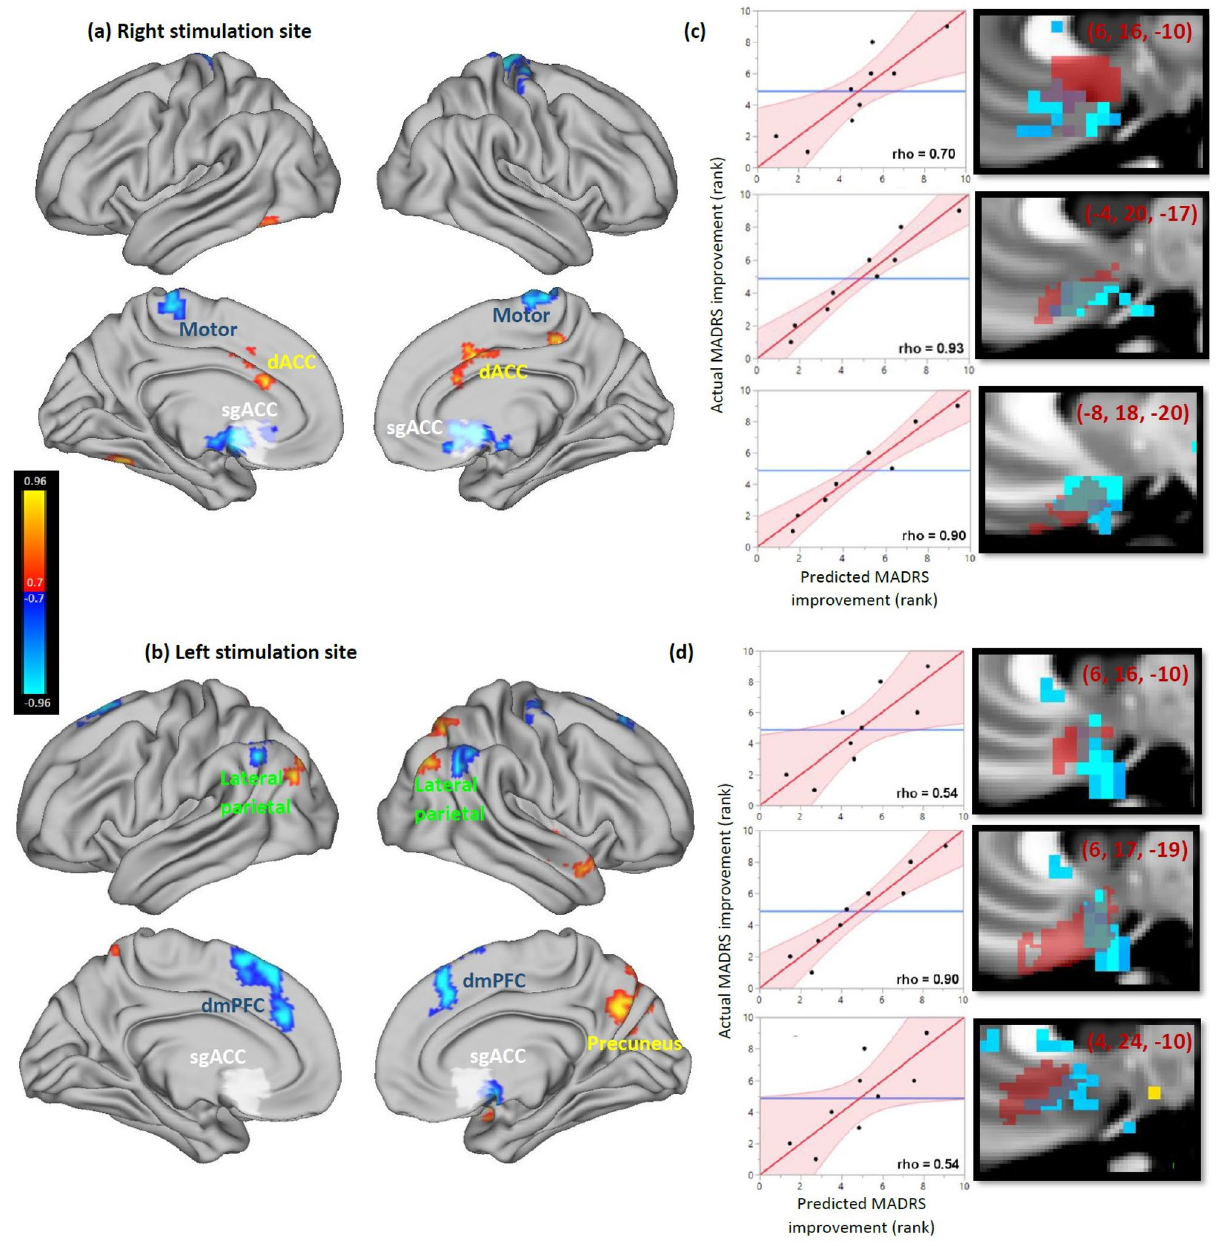
Figure 6. Connectivity profile associated with increased antidepressant efficacy of stimulation sites. White regions depict the a priori subgenual ROI. Clusters detected with threshold of r > 0.8 (uncorrected p < 0.001), minimum extent of 729 mm 3 , and cluster significance defined at p < 0.05. ( a ) Antidepressant response was significantly predicted by right stimulation site anti-correlation with bilateral sgACC, anti-correlation with motor cortex, and positive correlation with dorsal ACC (corrected p < 0.05). ( b ) Antidepressant response was significantly predicted by left stimulation site correlation with right precuneus and anti-correlation with right sgACC, bilateral lateral parietal lobe, and bilateral dorsomedial prefrontal cortex (corrected p < 0.05). ( c , d ) Antidepressant response was inversely related to seed-based connectivity of both stimulation sites with contralateral subgenual regions defined by a more recent cortical parcellation. Left panels depict the relationship between predicted and actual MADRS improvement, while right panels depict the overlap between the corresponding ROI (red) and the voxels whose stimulation site anti-correlation predicts MADRS improvement (blue). MNI coordinates of the center of each ROI are reported in maroon. ( c ) Right stimulation site connectivity with the a priori subgenual ROI (predicted MADRS change) was significantly predictive of antidepressant response (rho = 0.70, p = 0.035). This relationship was stronger when using exploratory subgenual ROIs based on a more recent cortical parcellation (rho = 0.90 and 0.93, p = 0.0009 and 0.0003). ( d ) Left stimulation site connectivity with the a priori subgenual ROI (predicted MADRS change) appeared to predict antidepressant response, but this relationship did not reach significance (rho = 0.54, p = 0.13). One of the two exploratory subgenual ROIs was significantly predictive of antidepressant response (rho = 0.90, p =